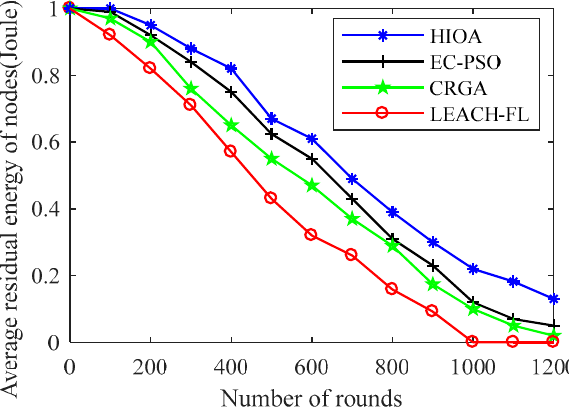
Figure 8. Average residual energy over rounds.